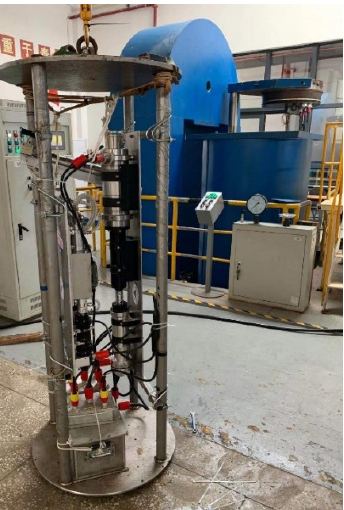
Figure 12. Deployment of high-pressure test.